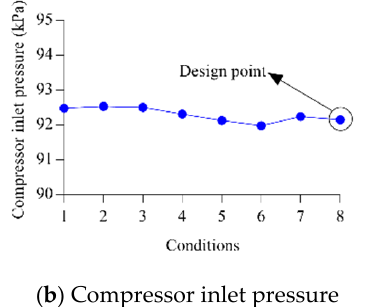
Figure 7. The field data of the upload process.